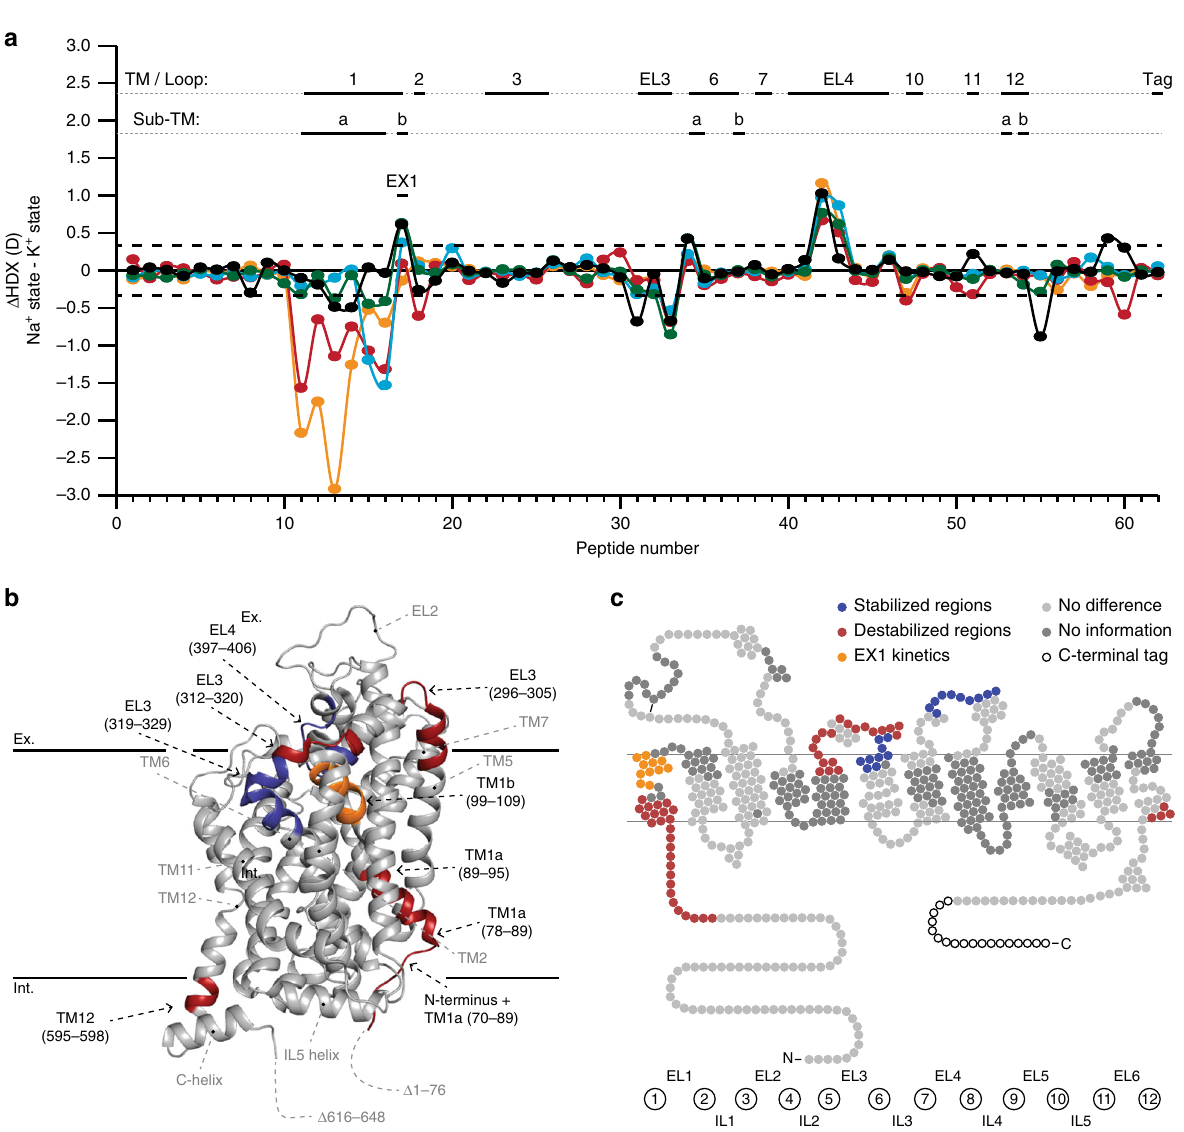
5-HT binding, we measured the HDX of hSERT in the presence of 5-HT (10 µM) and compared it to the Na + -bound state (Figs. 1 and 3). 5-HT induced signi fi cant changes in the dynamics of the protein resulting in HDX distinguishable from that observed when the transporter was in the presence of either K + or Na + (Fig. 3). Similar to K + , 5-HT binding increased HDX in the N- terminal tail immediately prior to TM1a (residues 70 – 83). This domain includes a conserved arginine residue (Arg79), which has